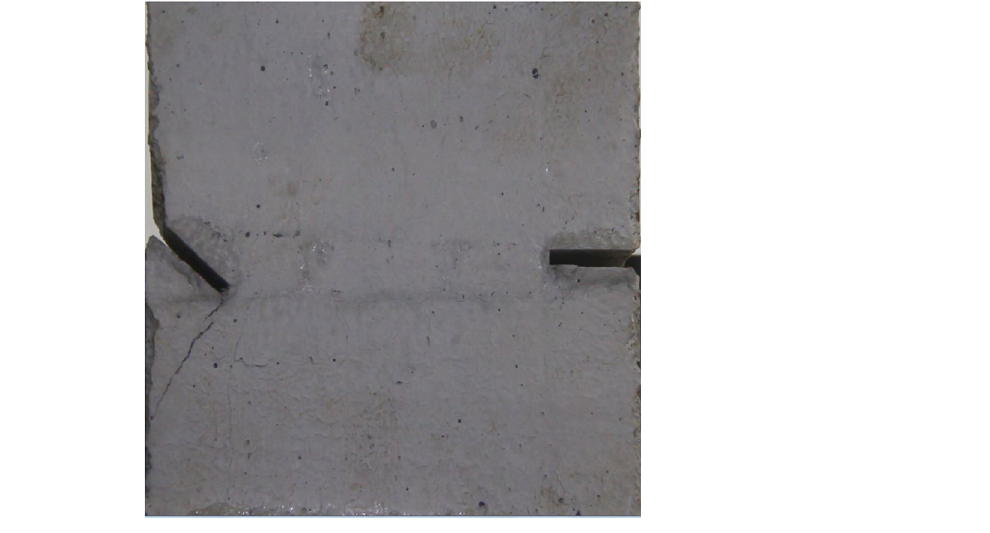
Figure 9. Photograph of a specimen showing tensile wing crack